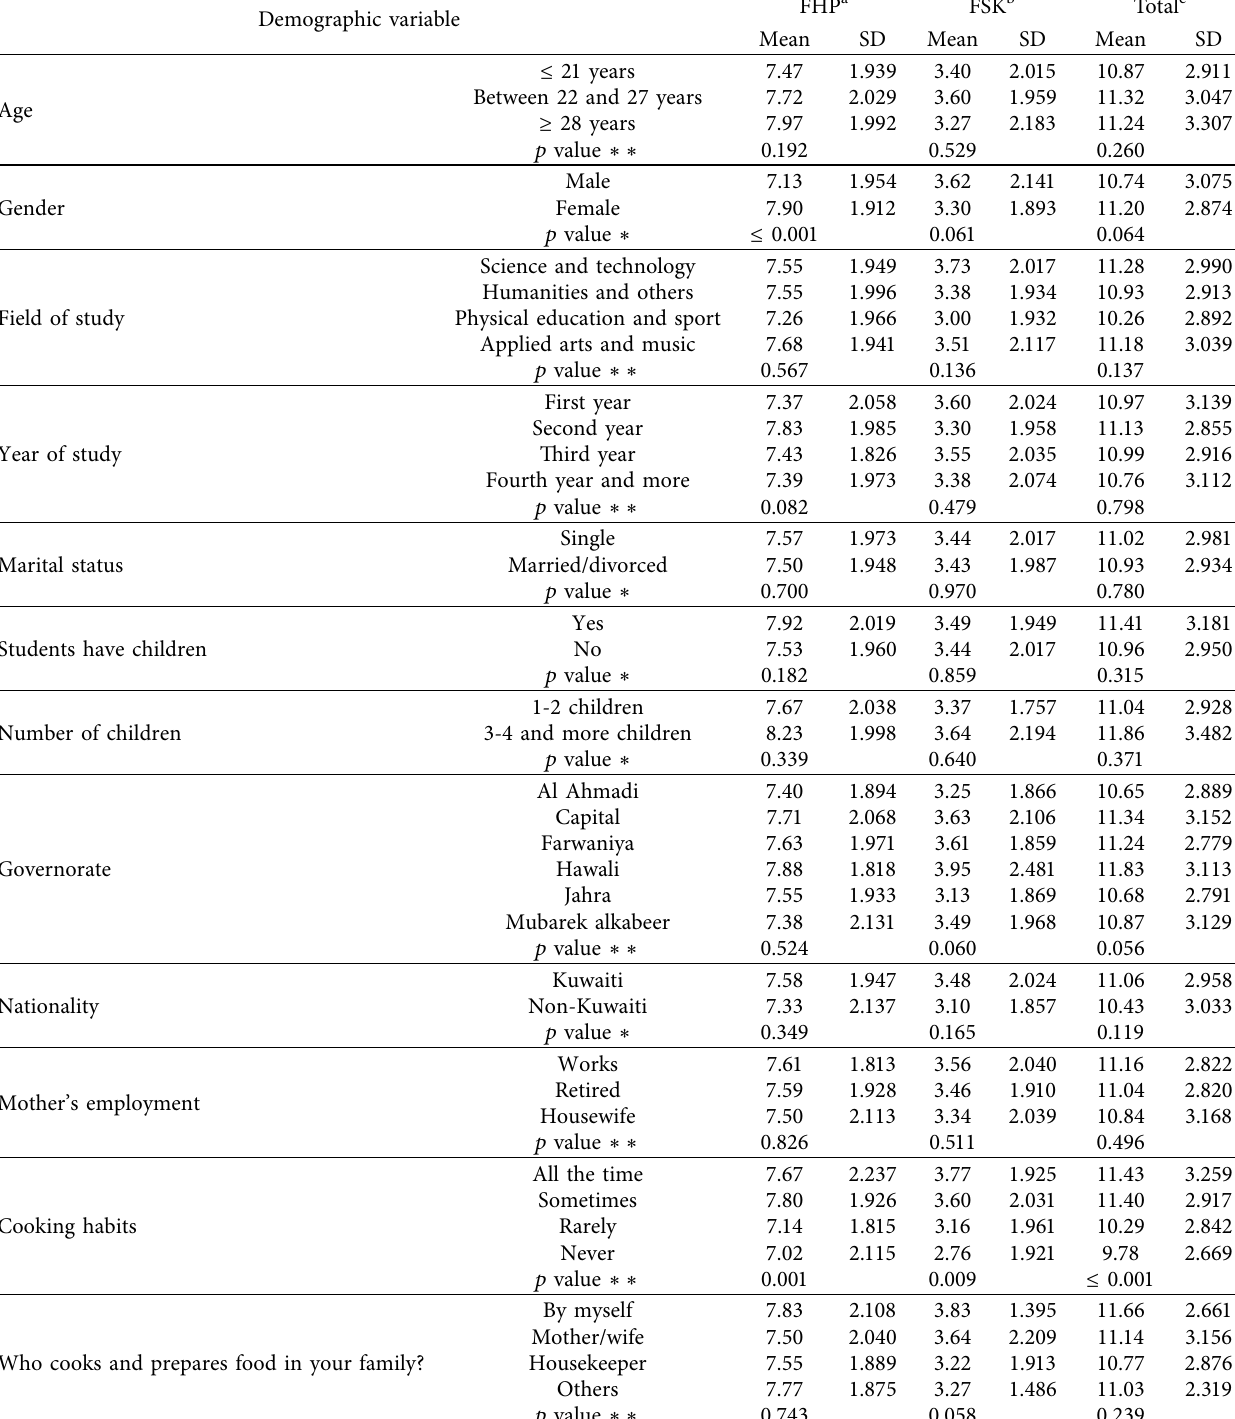
Table 2: Mean scores for food handling practices, food safety knowledge, and total scores for each demographic